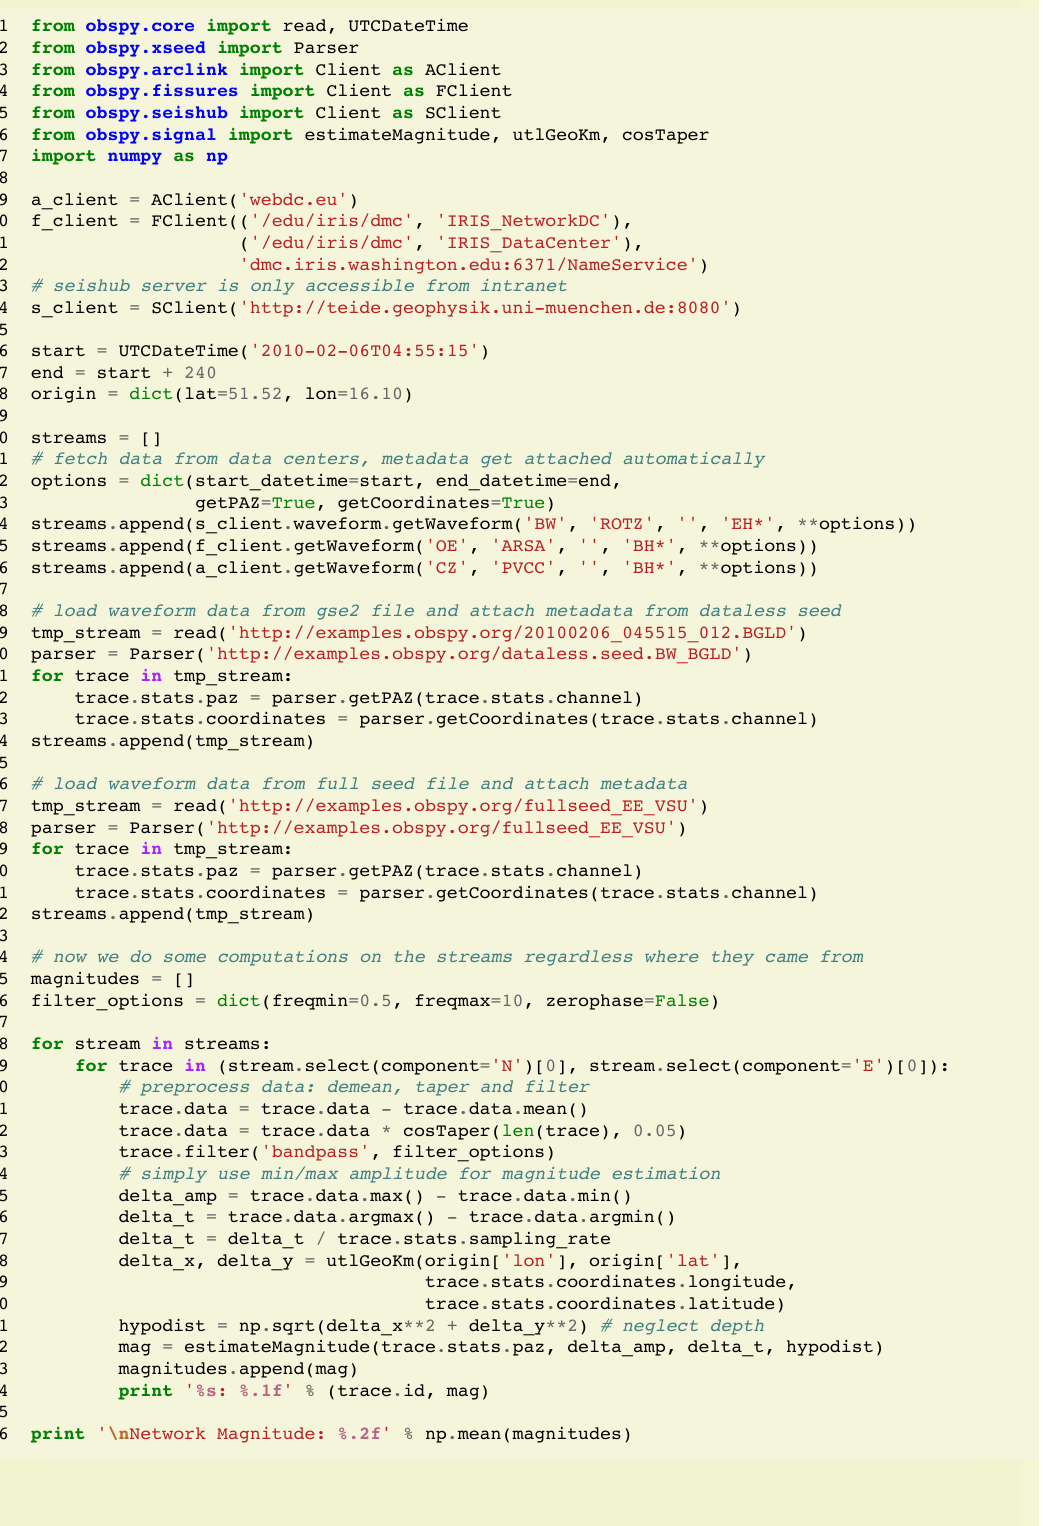
Figure 14. Example code: This program shows how to fetch data from different servers, read data from local files (in the example, read from a web server) and do batch processing on all of the streams